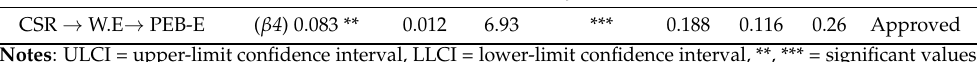
Table 6. Mediation results for H4. Path Estimates